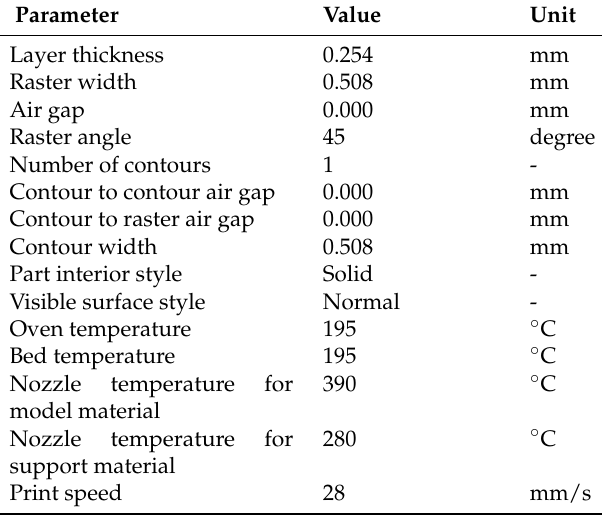
Table 2. Fixed process parameters along with their nominal